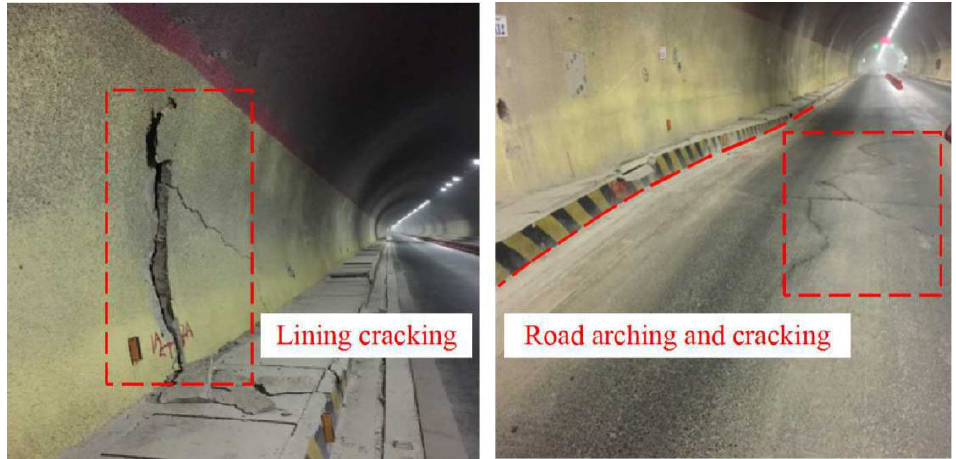
Figure 1. Swelling disaster of Dugongling tunnel in Shanxi province.